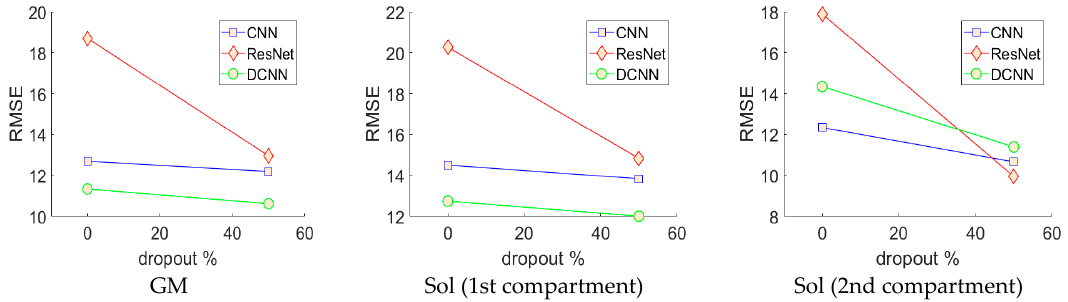
Figure 4. Neural network cross-validation. This graphic depicts how the error changes with respect to the percentage of dropout enabled in the fully connected layers of the CNN, ResNet and DCNN. These results show that dropout lowered RMSE, with 50% dropout enabled, revealing the optimal model for each architecture. Notice the ResNet without dropout enabled suffers from severe over-fitting. Table 1. Table of results per muscle/compartment. This table shows results computed by comparing predictions of each method, over all pixels (128 × 128 = 16,384), to the ground truth. Namburete, Muscle Error Measure